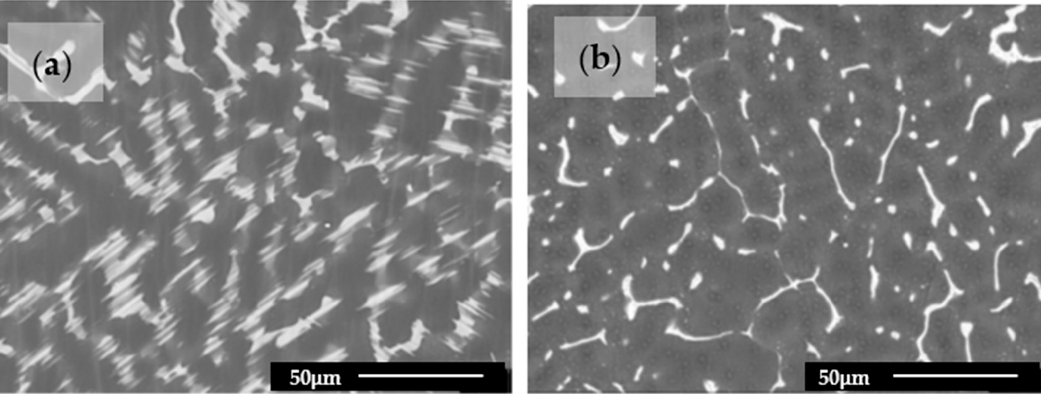
Figure 2. ( a ) Backscattered electron mode of scanning electron microscopy of the Mg 97 Zn 1 Y 2 cast alloy and ( b ) the alloy recovered after being annealed at 3 GPa and 823 K.